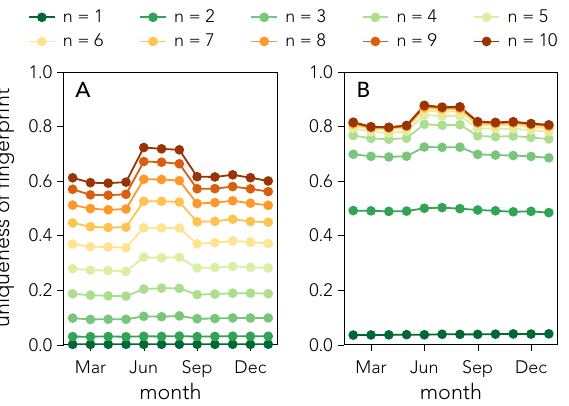
Figure 3. Temporal variations of uniqueness over 12 months. The fraction of individuals which we can re-identify by using n apps (1–10) changes from month to month, revealing that uniqueness has a temporal component, and that people are more unique during certain months. This is independent of whether apps are selected according to the random attack scheme ( A ) or the popularity scheme ( B ). Compared to Fig. 2, the fraction of re-identified individuals per month is lower because we have segmented behaviour into monthly fingerprints as compared to constructing fingerprints from 12 months of data. Each data point is rescaled proportional to the number of apps in each month so that uniqueness values are comparable even with a changing size of app set (see Fig.